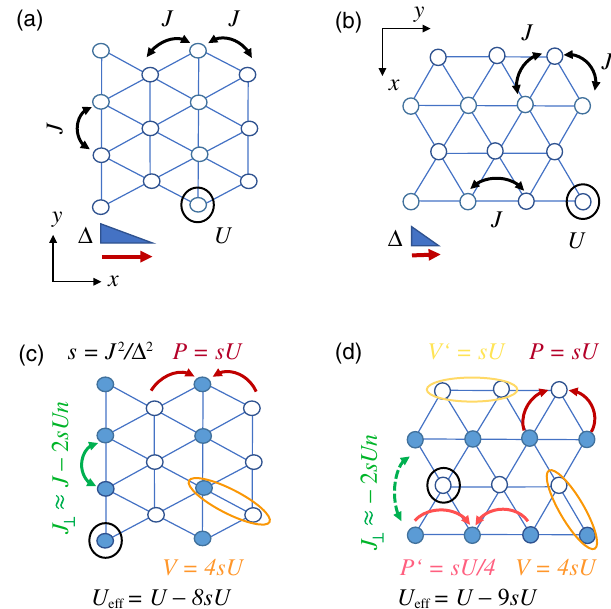
FIG. 6. Effective Hamiltonian for the tilted lattice. Visualization of the tight-binding model of the tilted lattice with energy offset Δ , on-site interaction U , and direct hopping J (a),(b) and of the respective effective models including nearest-neighbor inter- actions V and pair tunneling P as well as transverse tunneling J ⊥ and effective on-site interaction energy U (c),(d). Compared eff to the usual tilt direction (a),(c), the perpendicular tilt direction (b),(d) gives rise to a smaller perpendicular hopping J ⊥ as well as additional terms arising from resonances across two lattice sites (the primed quantities V 0 and P 0 ). The expression for the perpendicular hopping J ⊥ in mean-field approximation contains the mean on-site occupation n .